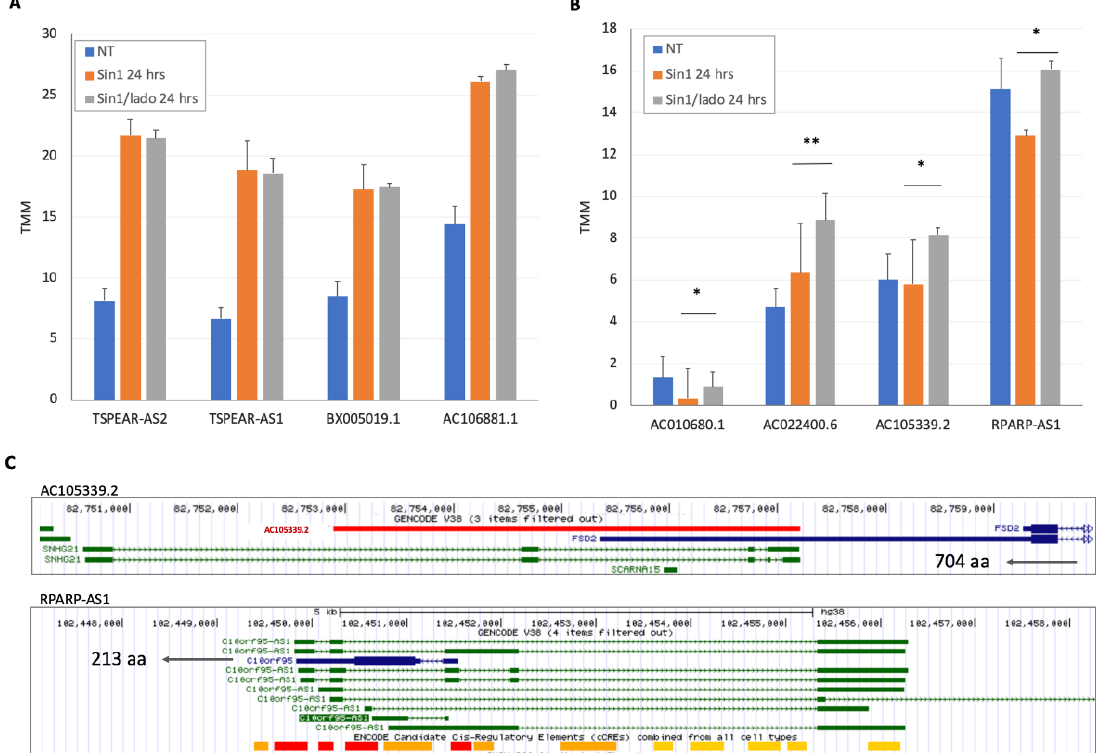
Figure 5. Sample of the lncRNAs by the measured expression levels in naïve untreated cells (NT), cells exposed to Sin1 (24 h) with or without ladostigil. ( A ) The transcripts shown are those with maximal induction by Sin 1 relative to NT. The average TMM and the standard deviations from biological triplicates are shown for each experimental group. ( B ) The transcripts shown are those with a maximal effect by ladostigil in the presence of Sin1. The average TMM and the standard deviations from biological triplicates are shown for each experimental group. The statistical significance with the p -value FDR ranging from 0.05 – 0.005 is depicted by * and <0.005 by **. ( C ) The genomic segments of AC105339.2 and RPARP-AS1 cover 10 and 12k nucleotides, respectively. AC105339.2 and RPARP-AS1 show the overlap between the lncRNA transcript and the gene in the vicinity. AC105339.2 acts as antisense to FSD2 (704 aa) and RPARP-AS1 is the antisense for C10orf95 (213 aa). Numerous transcripts of RPARP-AS1 are shown above the ENCODE annotations for enhancers (red) and proximal promotors (yellow).